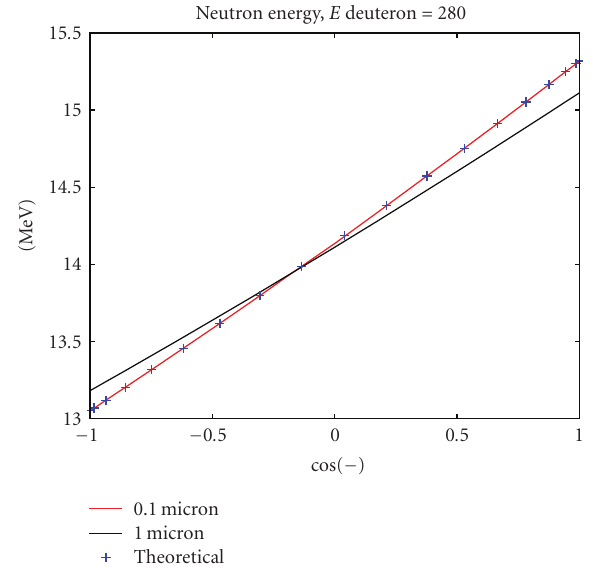
Figure 7: Ti target thickness e ff ect on D-T energy-angle depen- dence.